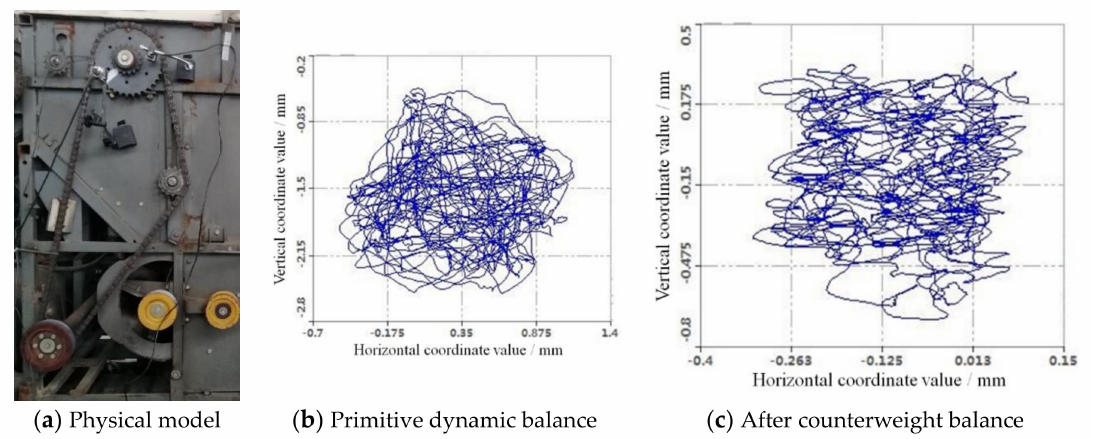
Figure 13. Axial trajectory of single threshing drum